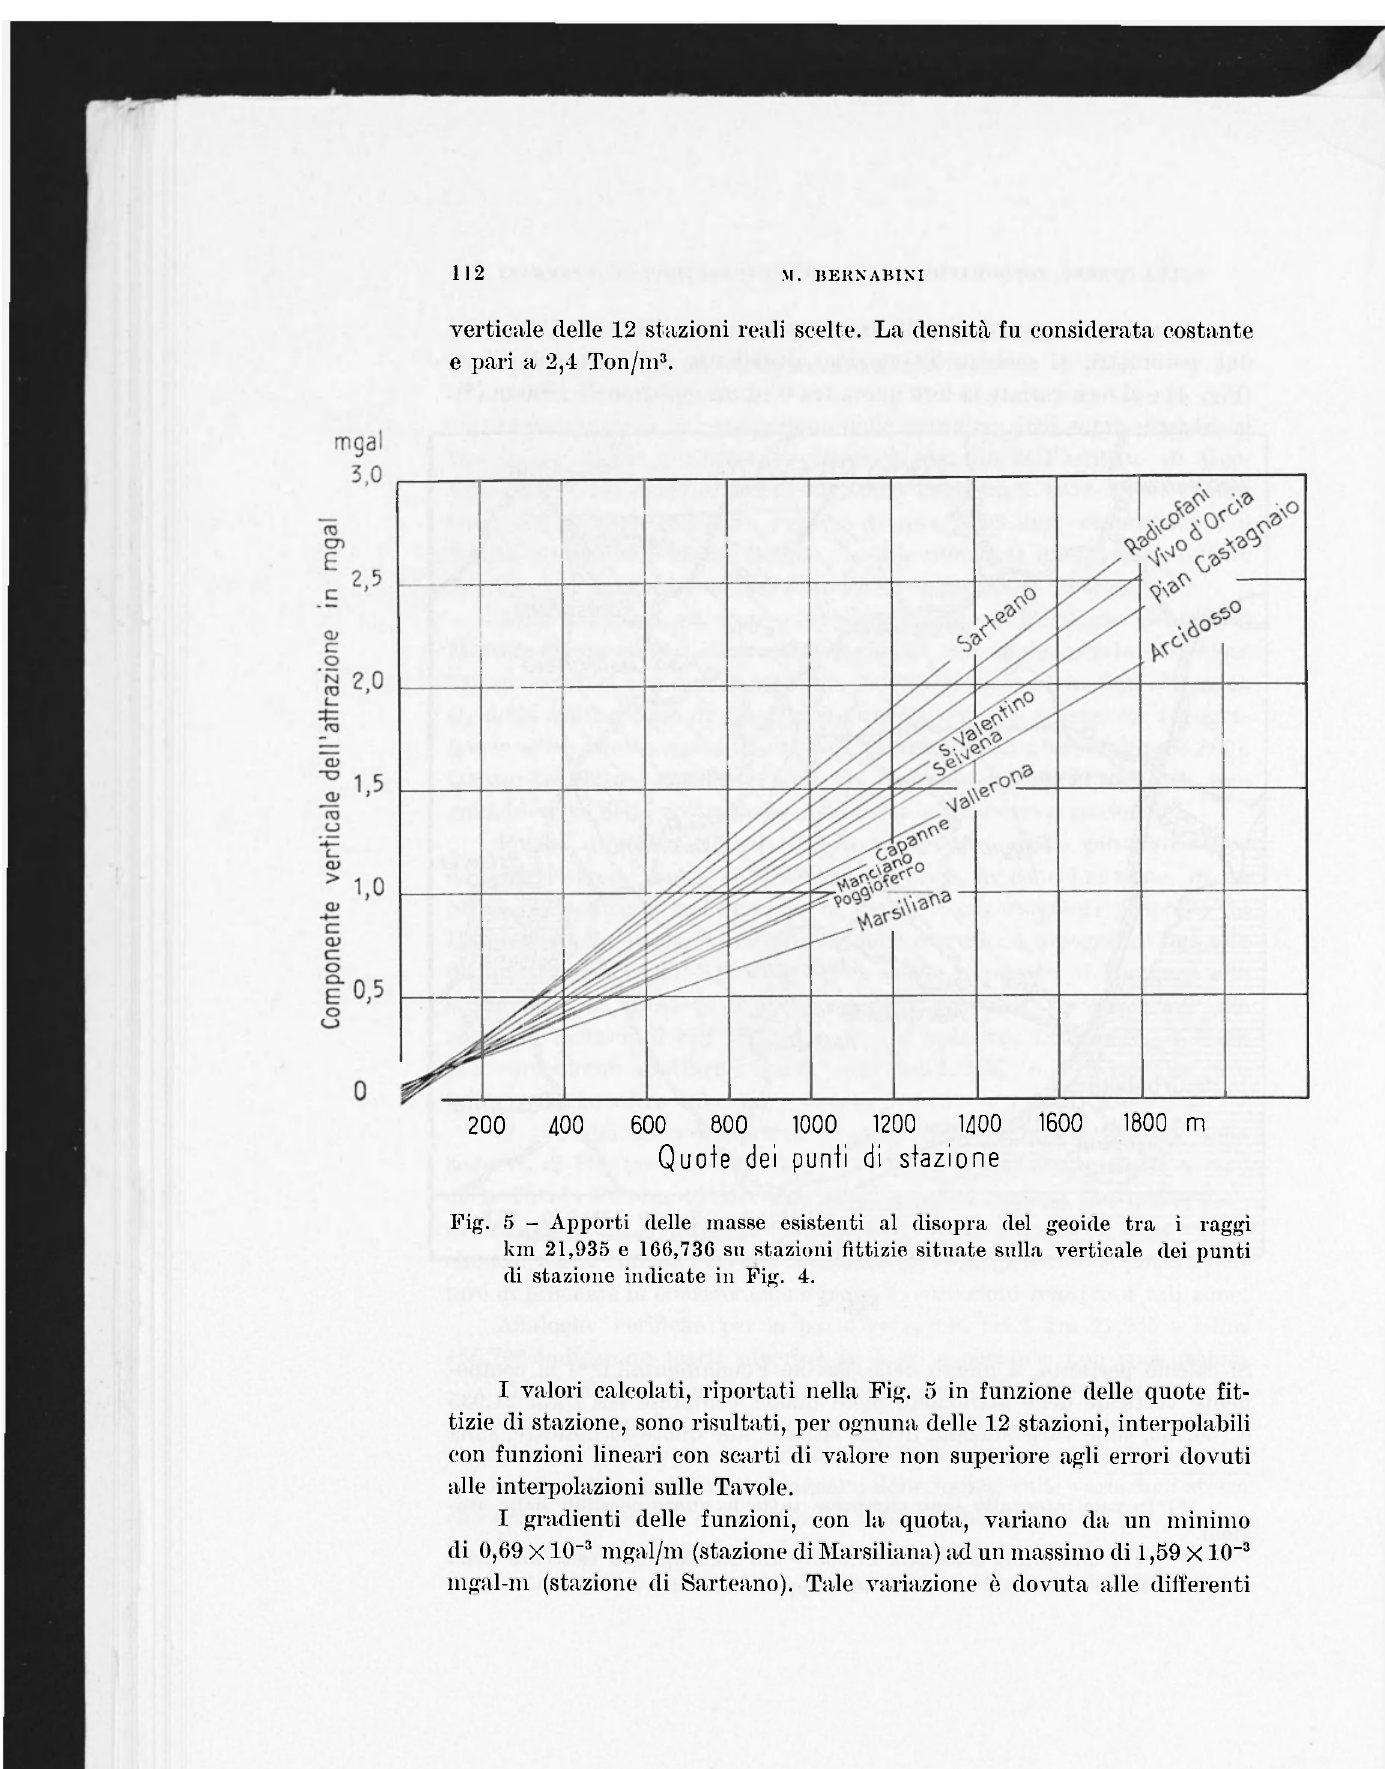
Fig. 5 - Apporti delle masse esistenti al disopra del geoide tra i raggi km 21,935 e 106,730 su stazioni fittizie situate sulla verticale dei punti di stazione indicate in Fig.